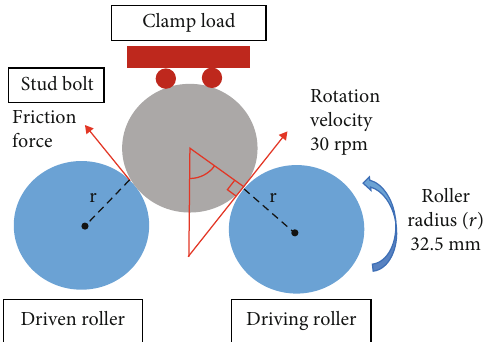
Figure 7: Theoretical analysis model to predict sliding between the roller and the stud bolt.